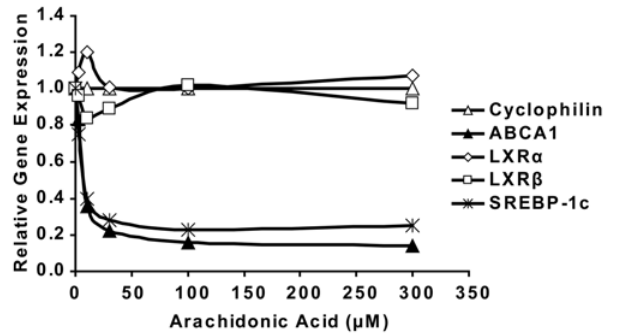
Figure 7. Arachidonic acid suppresses ABCA1 expression in WT SMCs. The indicated amount of arachidonic acid was administrated to WT SMCs to examine its effect on the expression of ABCA1 and LXRs. Cyclophilin was used for normalization and SREBP-1c, another LXR target gene, was measured as a positive control. Cells were incubated with the indicated amount of arachidonic acid for 6 h prior to real-time PCR. Arachidonic acid potently suppressed ABCA1 transcription at a low concentration of 3 m M and reached its maximum inhibitory effect at